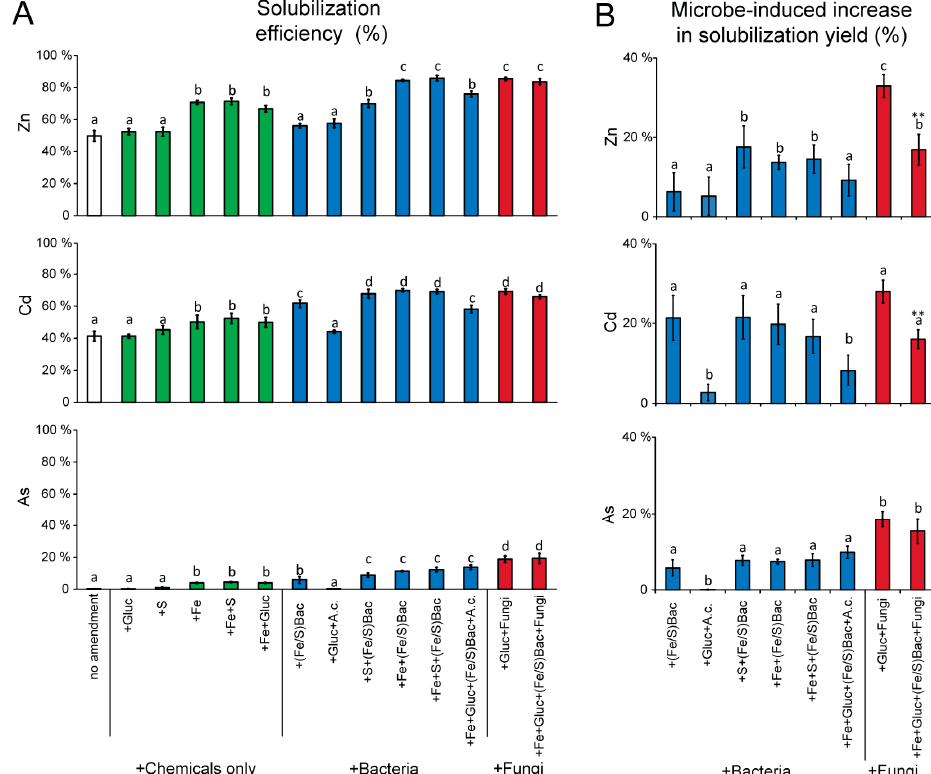
Figure 2. Bioremediation performance of the different combinations of chemical and microbial amendments and controls performed in this study. The left panel ( A ) shows the solubilization efficiency for Zn, Cd, and As. The right panel ( B ) shows the increase in solubilization yields induced by the addition of each different type of microbes (calculated by comparison with the respective chemical-only treatments without microbial addition). +Gluc: glucose addition; +Fe: iron addition; +S: sulphur addition; + Fe/S Bac: addition of chemo-autotrophic Fe/S oxidizing bacteria (including Acidithiobacillus ferrooxidans , Acidithiobacillus thiooxidans, and Leptospirillum ferrooxidans ); +A.c.: addition of the chemo-heterotrophic bacteria ( Acidiphilium criptum ); + Fungi: addition of fungal strains ( Aspergillus niger and Trichoderma sp. ). Different letters in the bar charts highlight significant differences among values. In the ( B ) panel, asterisks highlight significant differences between the values obtained with the addition of fungi alone, or of fungi and Fe/S bacteria.